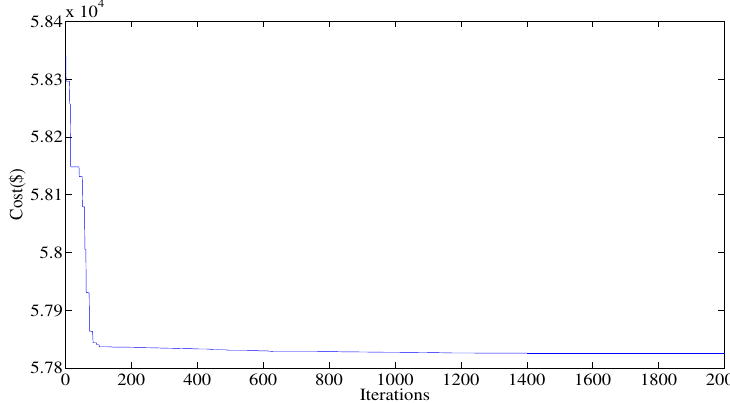
Figure 6. Distribution of total costs for 50 independent runs for 24-unit test system.